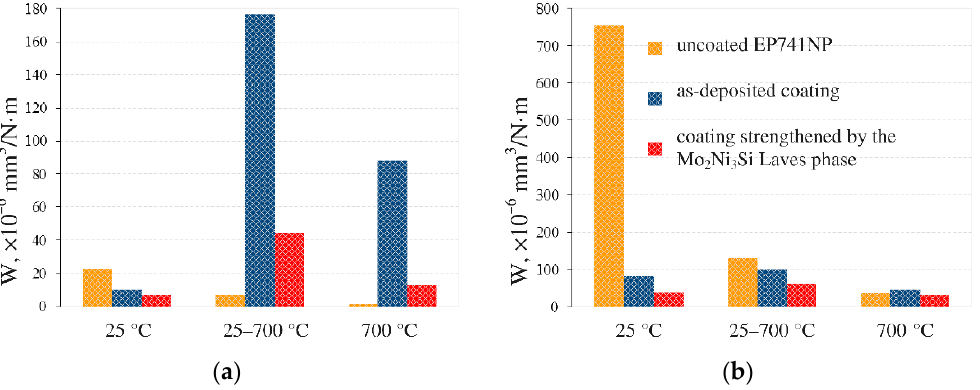
Figure 8. Wear rate of a friction pair at different temperatures: ( a ) for Al 2 O 3 balls and ( b ) for the substrate (uncoated and with coatings deposited onto it).